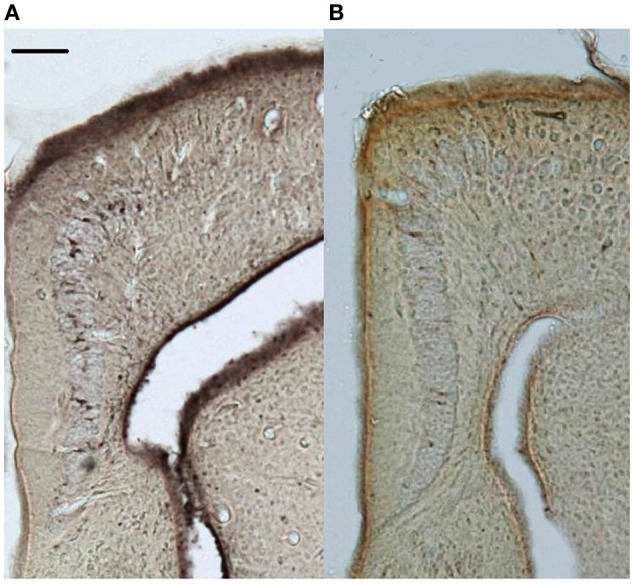
Representative doublecortin-stained sections (5x) of the medial cortices from (A) control and (B) supplemented territorial male side-blotched lizards (Uta stansburiana). Scale bar = 100 μm.